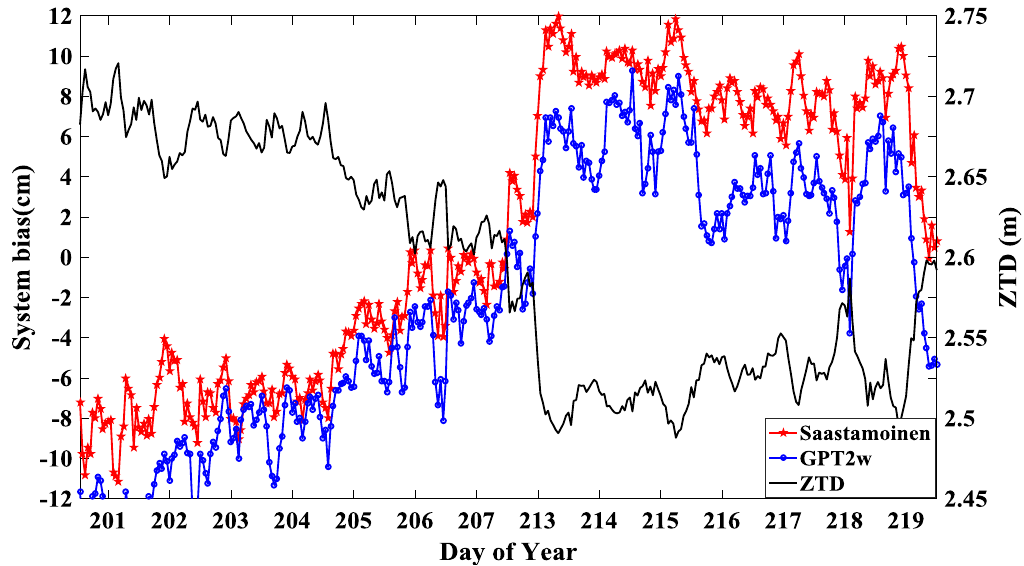
Figure 3. Time series of daily average ZTD in Hong Kong and Systematic bias of Saastamoinen and GPT2w model in two cases. GPT2w model in two